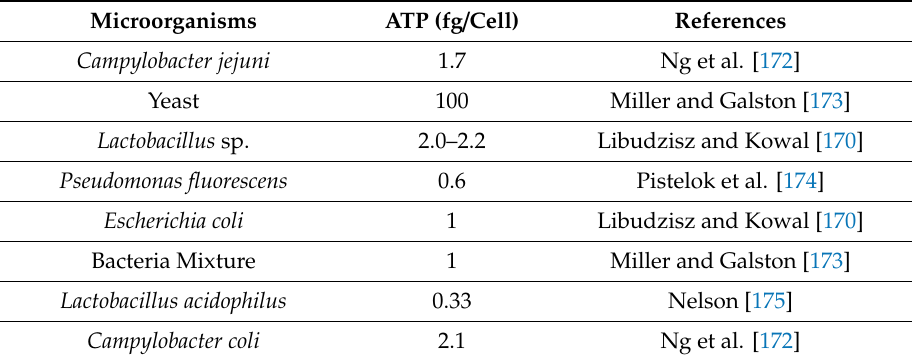
Table 4. The Content of ATP (fg / cell) in Some Bacterial, mold and Yeast